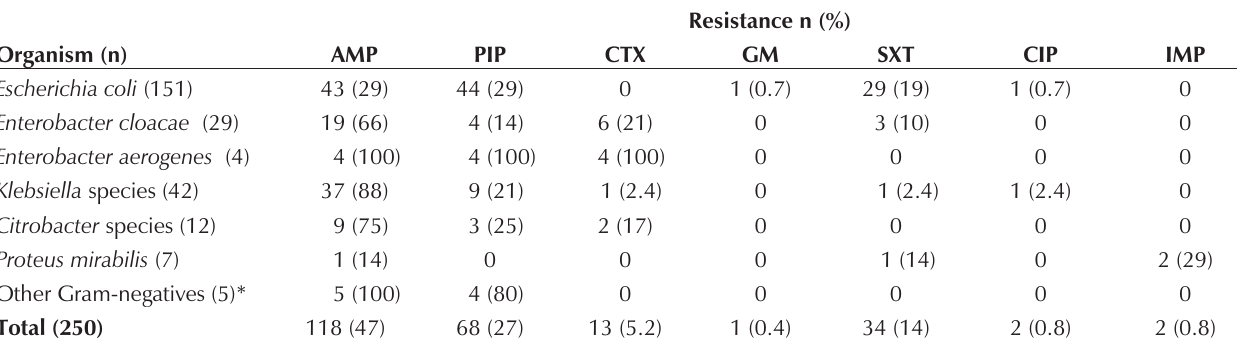
Resistance profiles of